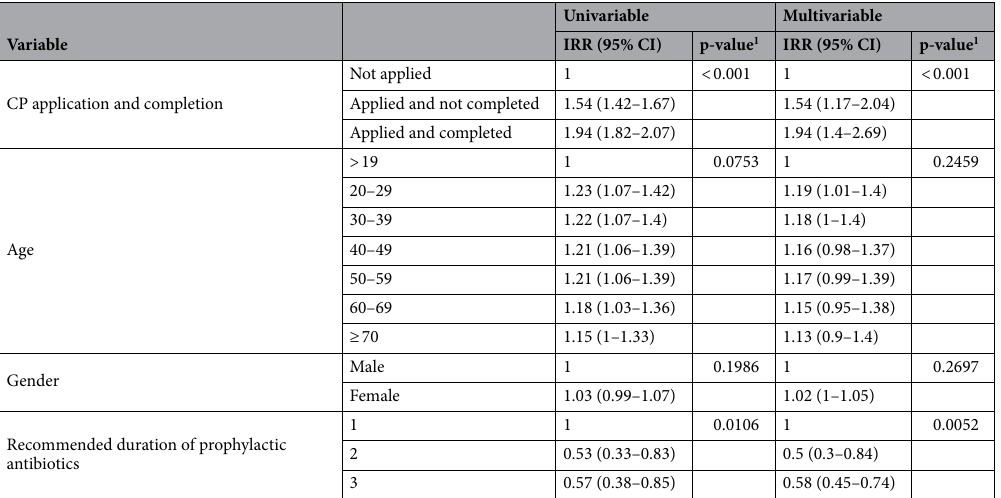
Table 3. Effects of clinical pathway (CP) application and/or completion effect on the adherence rate (n p = 23,469), and the incidence rate ratio (IRR) from a univariable and multivariable mixed-effect Poisson model with random effects. CI confidence interval. 1 p-value calculated using the log likelihood ratio test.